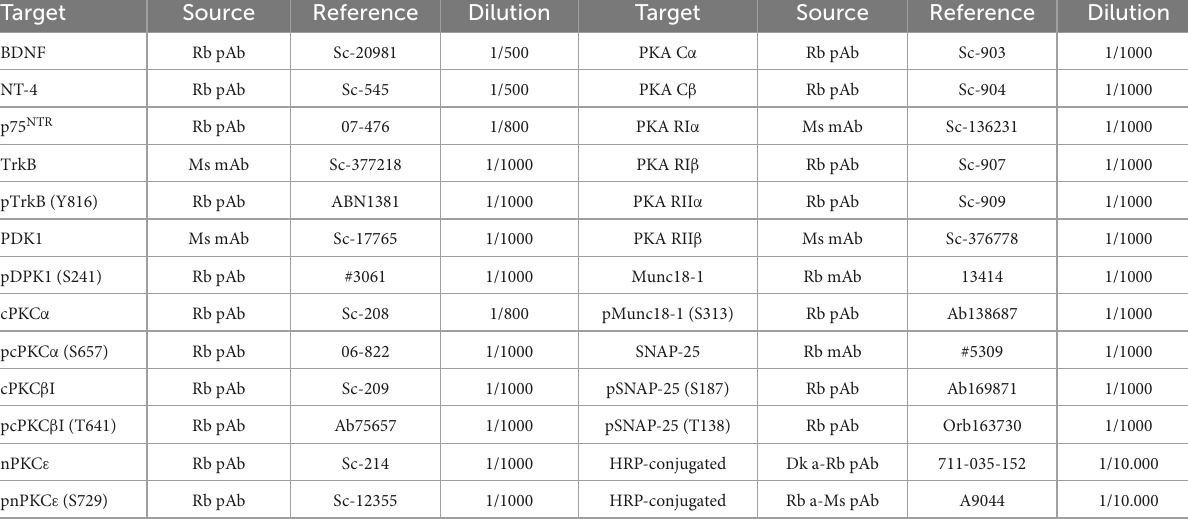
TABLE 1 List of primary and secondary antibodies used.